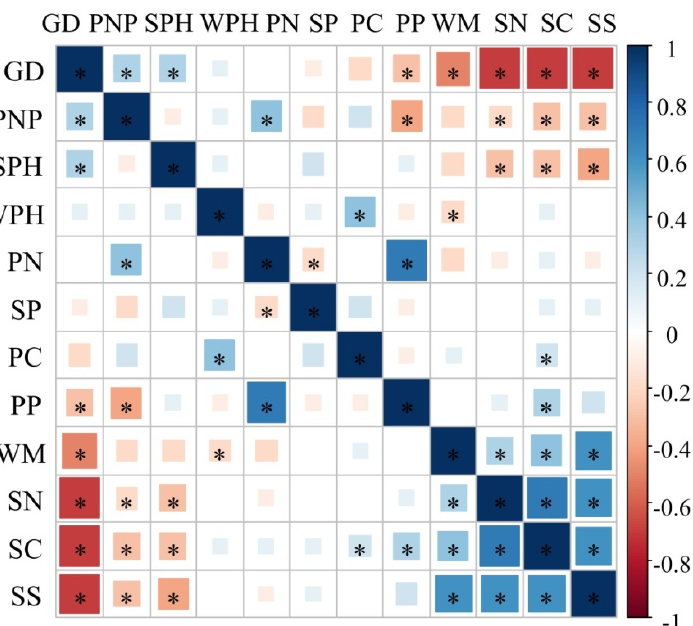
Figure 3. Relationships between groundwater, soil, and leaf ecological stoichiometry of A. sparsifolia at the study sites. GD, groundwater depth; WPH, groundwater pH; WM, degree of mineralization of groundwater; SS, soil salt; SPH, soil pH; SC, soil C concentration; SN, soil N concentration; SP, soil P concentration; PC, plant C concentration; PN, plant N concentration; PP, plant P concentration; PNP, plant N:P ratio. * Indicates significant correlation at p < 0.05.